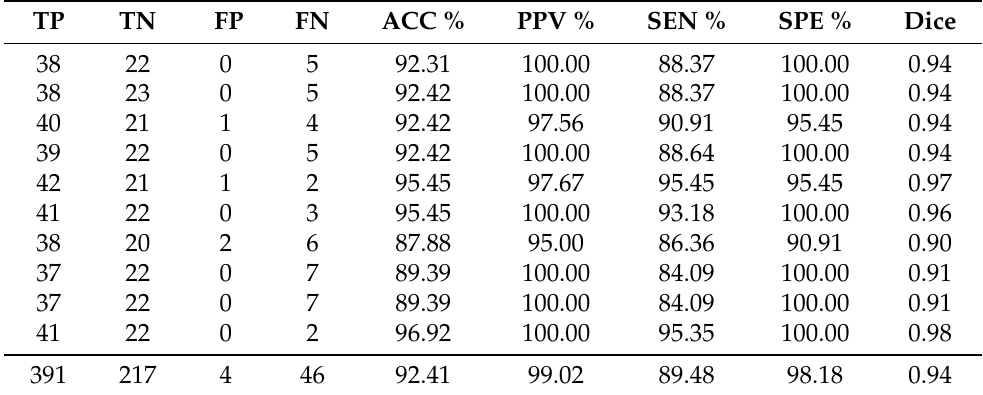
Table 3. SVM with a third order polynomial kernel. The first 10 rows in the table document the performance results for each individual fold. The last row states the averaged performance